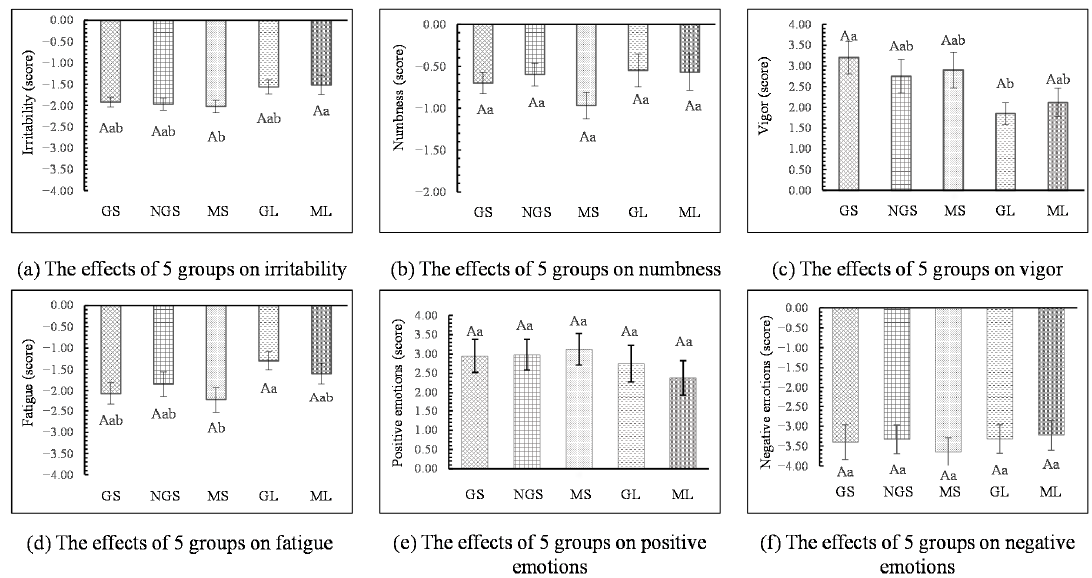
Figure 6. Comparison of the psychological restorative values after the participants viewed five ornamental bamboo groups: GS (green stalk), NGS (non-green stalk), MS (multicolored stalk), GL (green leaf), ML (multicolored leaf). The zero point represents the value measured after participants viewing urban images. n = 300; mean ± SE. Different capital letters: significant differences ( p < 0.01) between five groups. Different lowercase letters: significant differences ( p < 0.05) between five groups. The same letters: no significant differences.